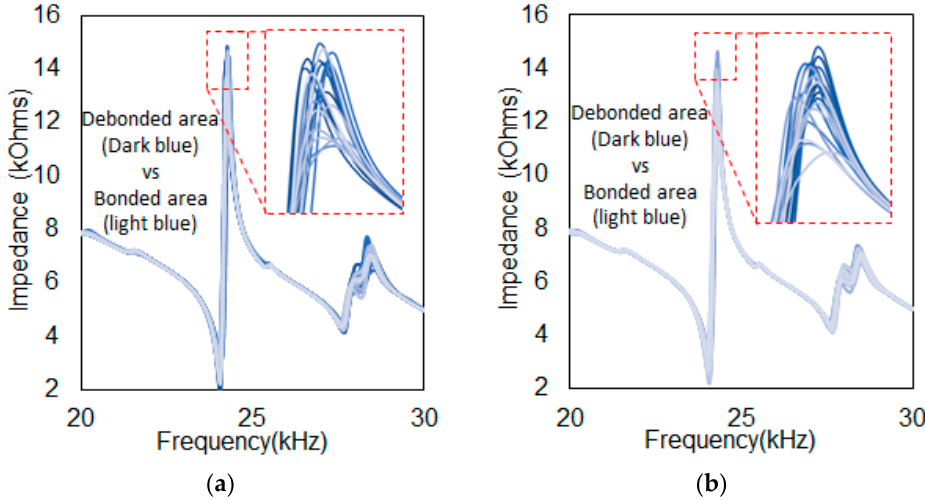
Figure 4. Impedance signatures measured from bonded and debonded areas using the roller PZT device for ( a ) 0.2 mm top plate; ( b ) 0.4 mm top plate. device for ( a ) 0.2 mm top plate; ( b ) 0.4 mm top